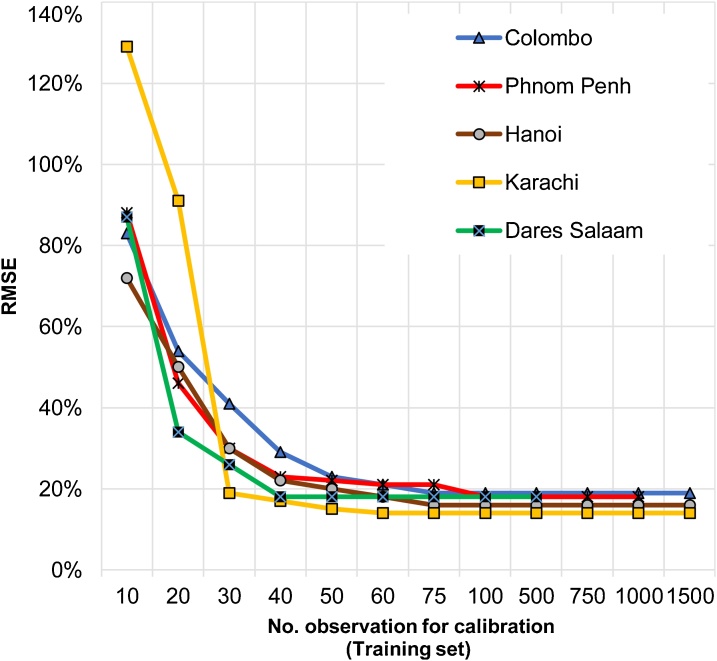
Variation of RMSE values according to the number of observations of the calibration sample.